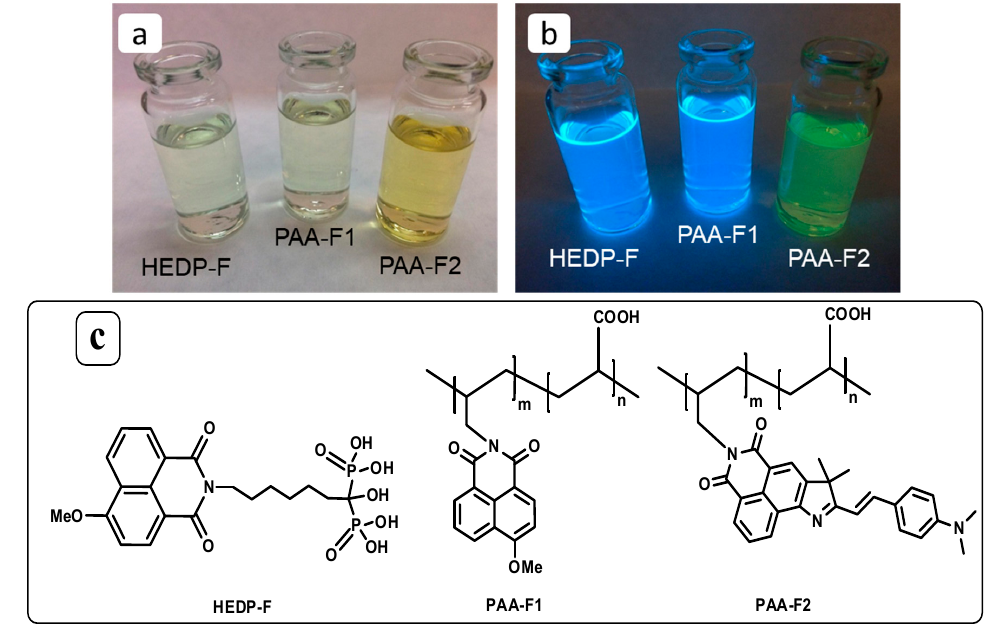
Figure 1. Photographs of aqueous solutions of the scale inhibitor’s HEDP-F, PAA-F-1, and PAA-F2 with a concentration of 5 mg/L under visible ( a ) and UV light ( b ), and chemical structures ( c ) of antiscalants (fluorescent fragment constitutes 1% mass of PAAF1 and PAA-F2).